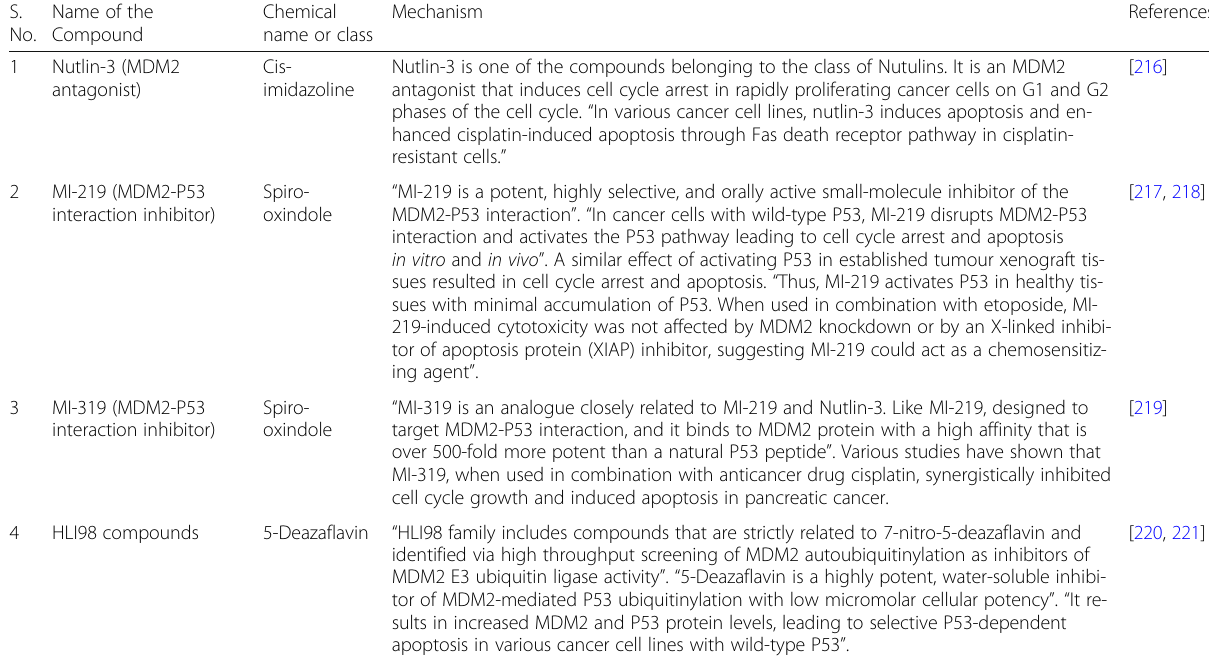
Table 3 Compounds that block MDM2-P53 interaction and reactivate TP53